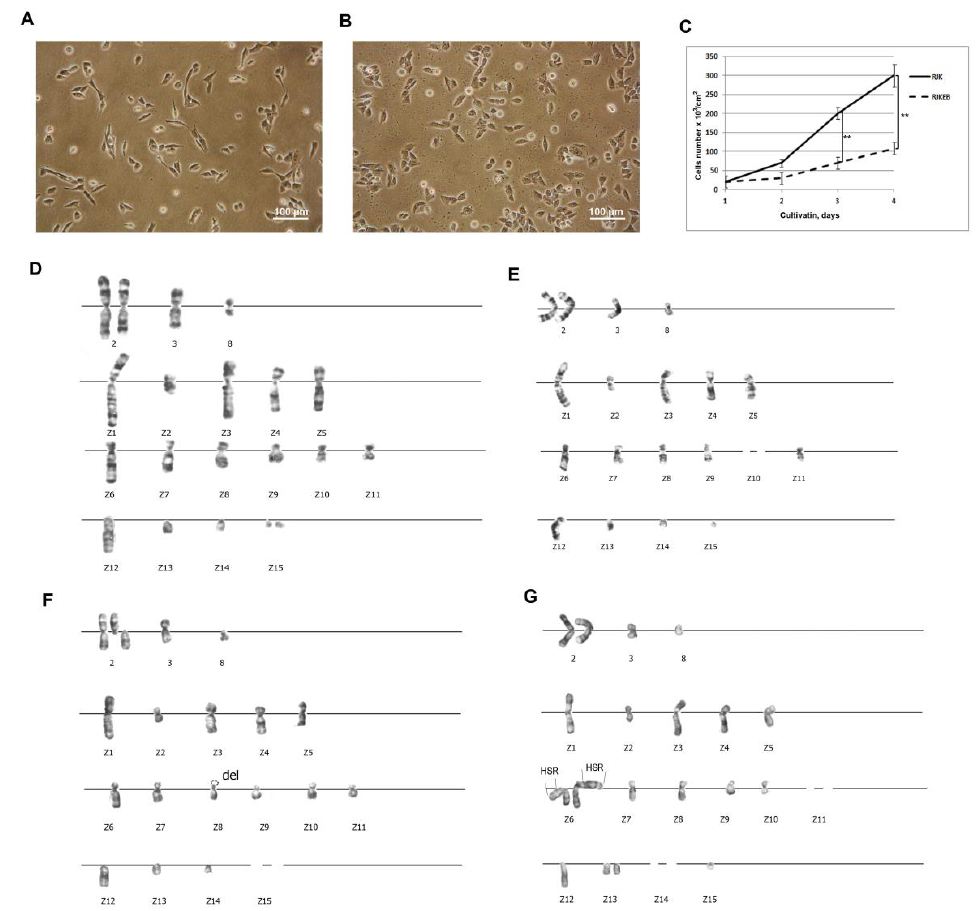
Figure 1. Characteristics of RJK and RJKEB cells. ( A ) RJK cells, live imaging, Ob: 10 × ; ( B ) RJKEB cells, live imaging, Ob: 10 × ; ( C ) RJK and RJKEB growth curves. To plot cell growth curves, the number of RJK and RJKEB cells was counted using FACS analysis for 4 days. The mean ± SD of three independent experiments (** p < 0.01); ( D ) standard RJK karyotype. 2, 3, 8—normal chromosomes. Z1-Z15—marker chromosomes. n = 20; ( E ) RJK karyotype with loss of chromosome Z10, n = 18; ( F ) karyotype with centromeric break in chromosome 2, del p terZ8, chromosome Z15 is absent. n = 18; ( G ) karyotype of RJKEB cells. A cell variant with two copies of the Z6 chromosome labeled with HSR of di ff erent lengths. Chromosomes Z11 and Z15 are absent. n = 18. Ob: 100 × . Abbreviations: RJK—Chinese hamster cells CHLV-79 RJK; RJKEB—RJK resistant to ethidium bromide; FACS—fluorescence-actevated cell sorting;